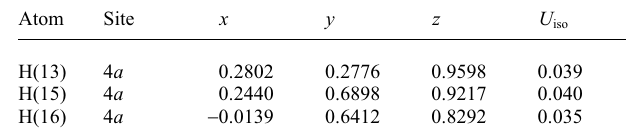
Table 3. Atomic coordinates and displacement parameters (in Å 2 ) .